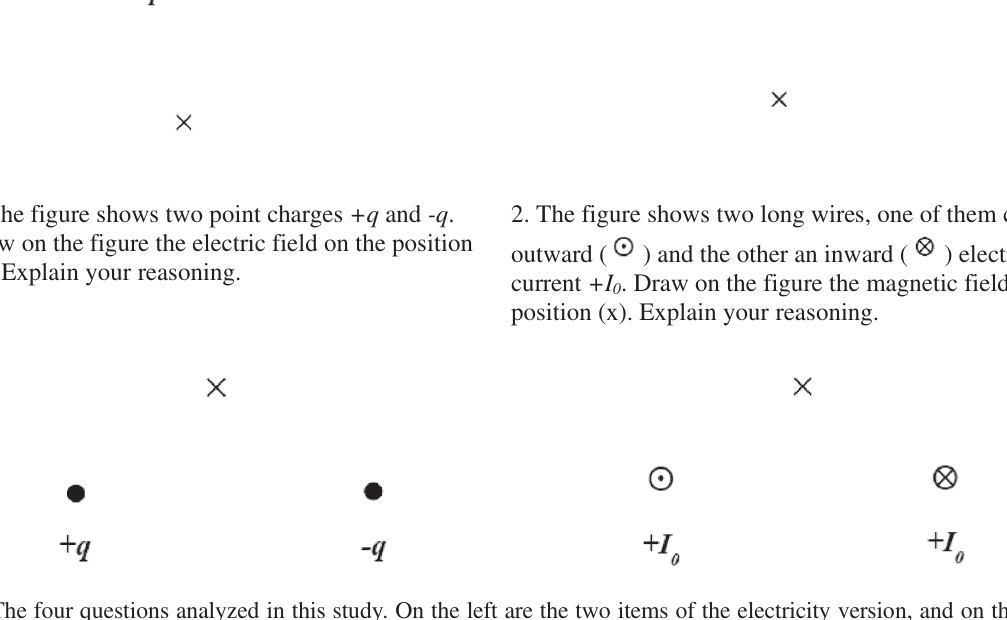
FIG. 1. The four questions analyzed in this study. On the left are the two items of the electricity version, and on the right, the same items of the magnetism version. The first question focuses on conceptual understanding of the electric and magnetics field ’ s magnitude and direction, through their drawings and explanations. The second question focuses on applying the superposition principle in the context of electric and magnetic fields,